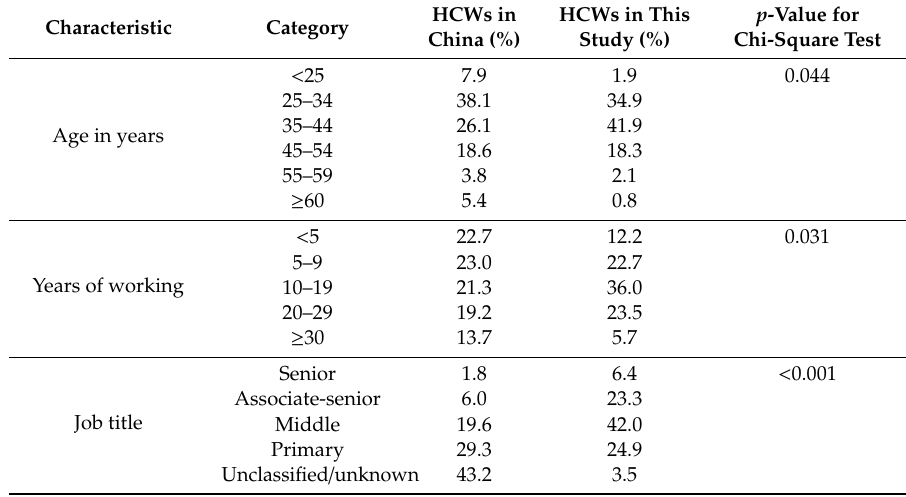
Table 1. Characteristics of healthcare workers surveyed and in China Health Statistics Yearbook